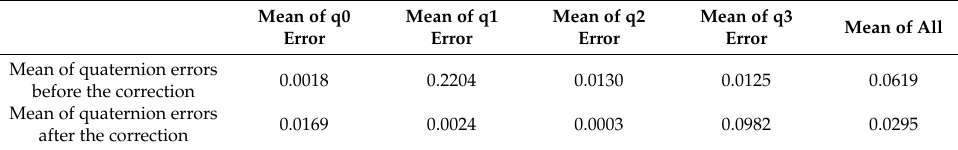
Table 7. Comparison of mean of errors of